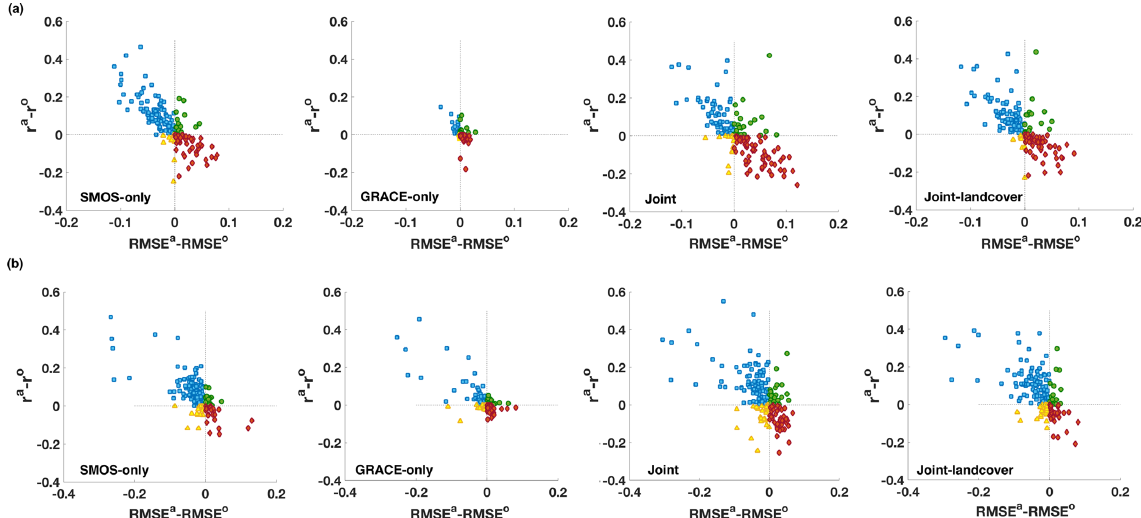
Figure 4. Performance of surface and root-zone soil moisture estimates from four data assimilation scenarios against open-loop: correla- tion ( r ) and root mean-squared error (RMSE) change after the assimilation ( r a − r o , RMSE a − RMSE o ; a : after assimilation, o : open-loop) in (a) surface soil moisture estimation; (b) root-zone soil moisture estimation. The four scenarios include SMOS-only as the assimilation of SMOS data alone, GRACE-only as the assimilation of GRACE data only, Joint as joint assimilation of SMOS and GRACE, and Joint- landcover as increasing SMOS uncertainty in forest regions in the joint assimilation. The points in the scatter plots are colour coded such that blue indicates ISMN sites where improvement was observed in both correlation and RMSE; green indicates sites where there was improve- ment in correlation, but not in RMSE; yellow indicates those sites where there was improved RMSE, but not correlation; and red indicates sites where assimilation resulted in degradation in both correlation and